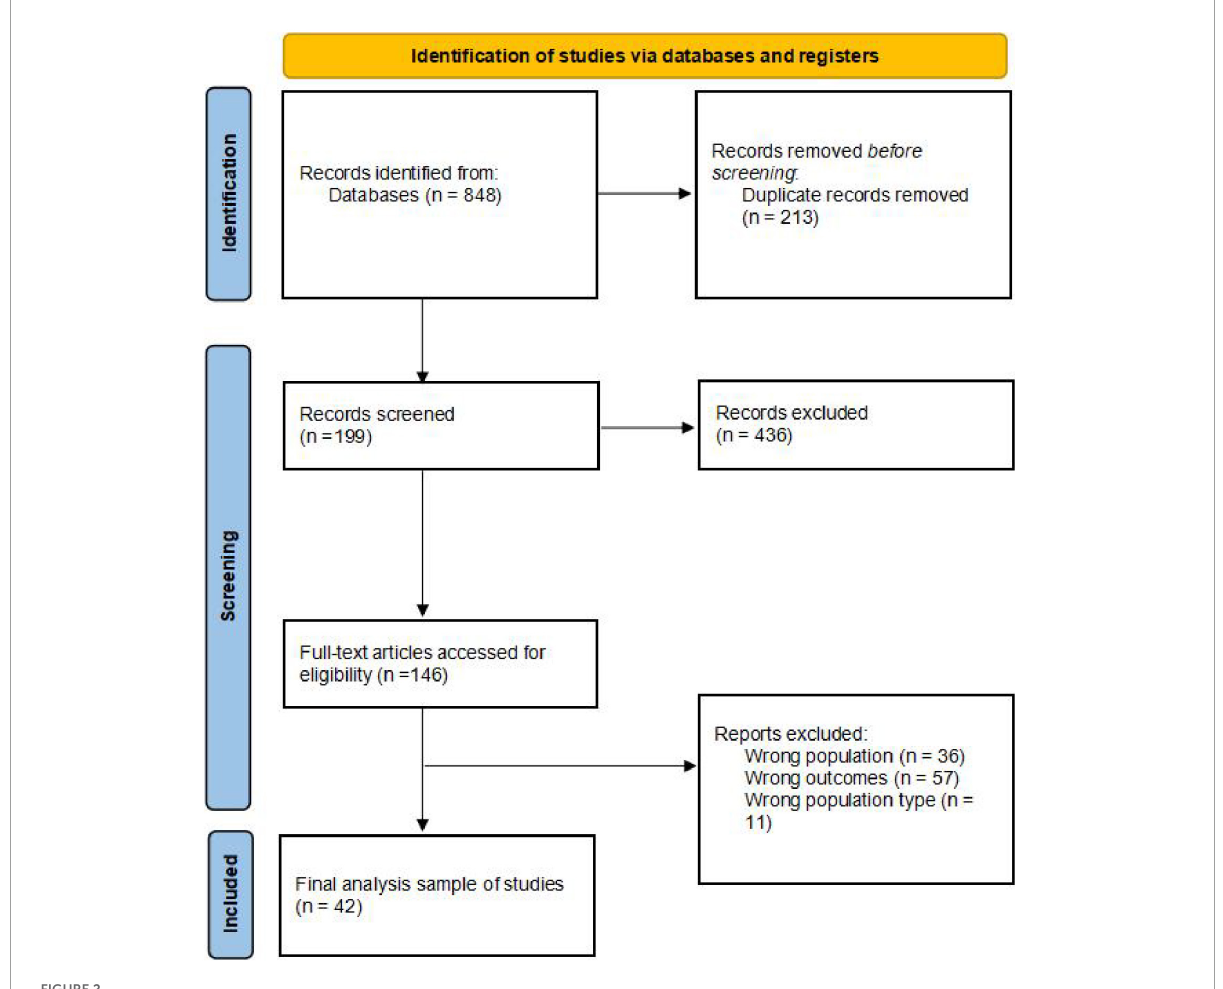
FIGURE2 The flow chart of the trial